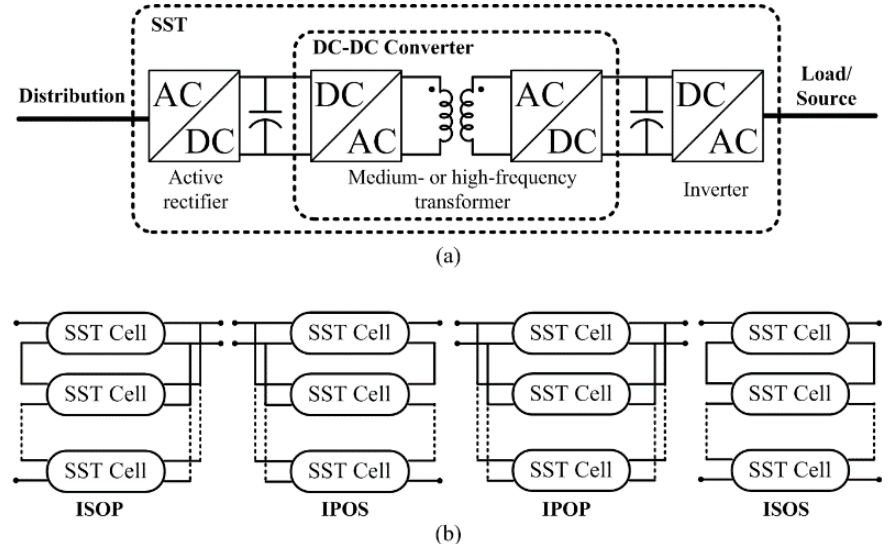
Figure 1. ( a ) The functional concept of an ac-dc-dc-ac three-stage solid-state transformer (SST) system and ( b ) various modular configurations of a SST system (ISOP: input-series output-parallel, IPOS: input-parallel output-series, IPOP: input-parallel output-parallel, ISOS: input-series output-series).